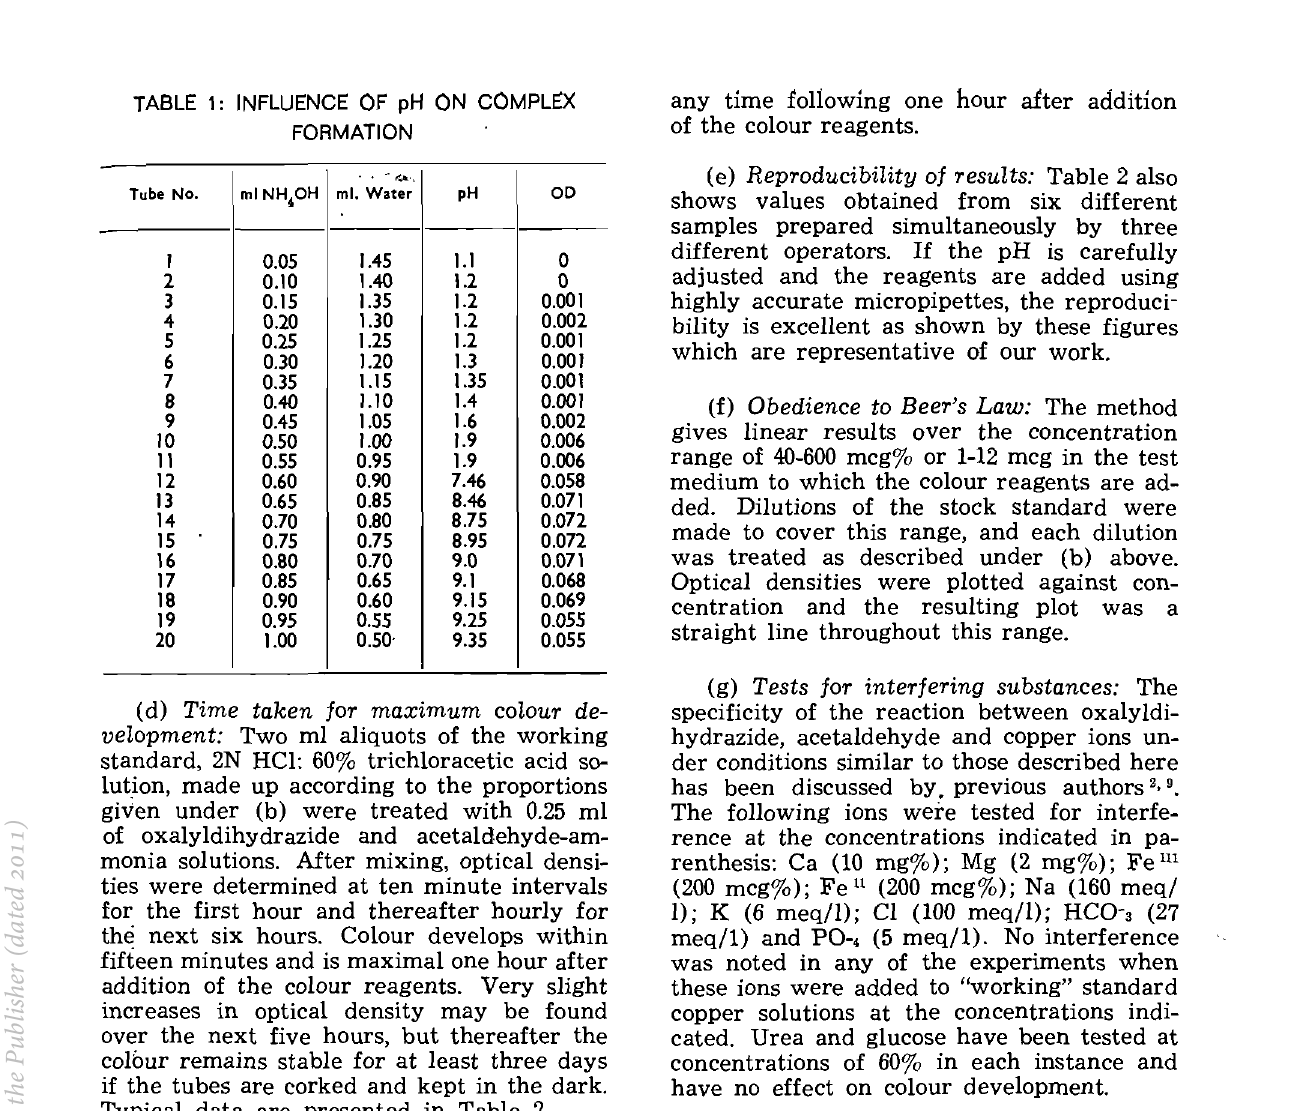
TABLE 2: THE INFLUENCE OF TIME ON COLOUR DEVELOPMENT Tube